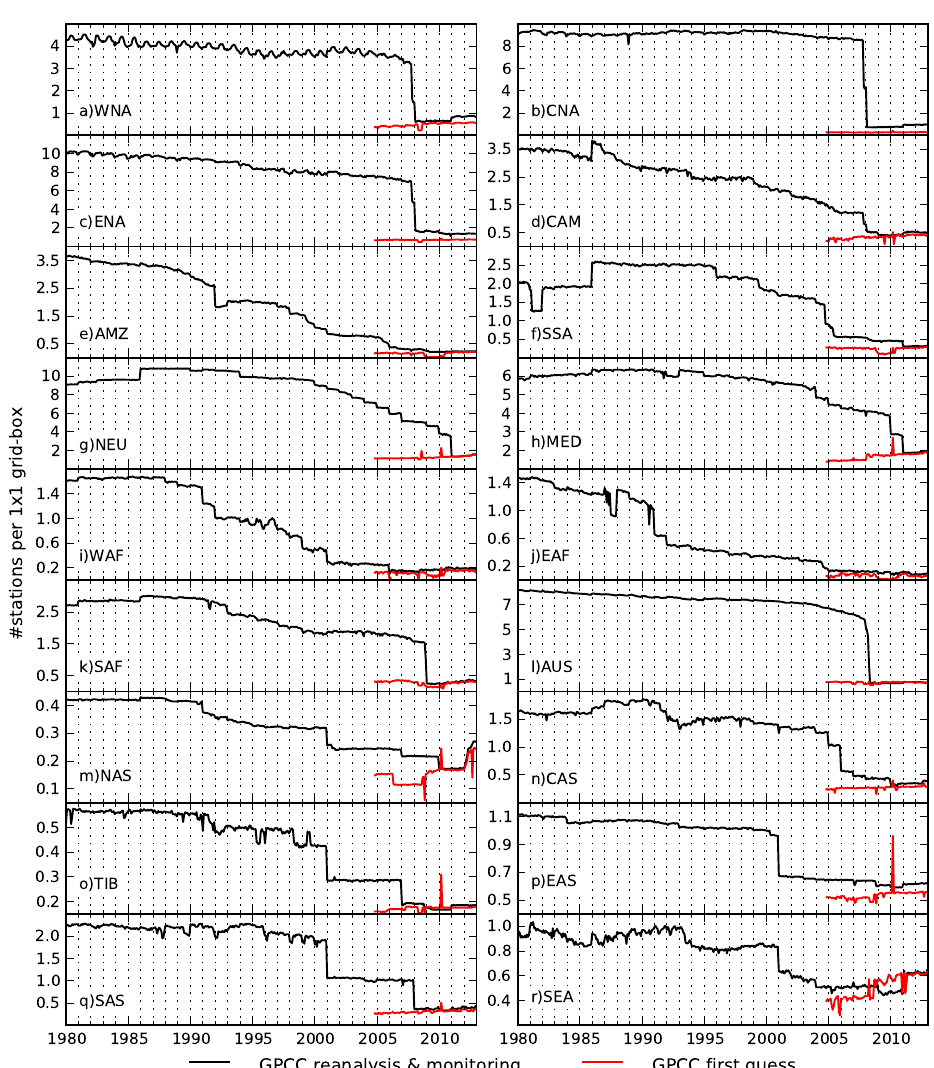
Figure 1. Monthly temporal evolution of the mean number of stations per 1 ◦ × 1 ◦ grid box in the different regions (see Table 2) present in the GPCC reanalysis (until 2010) and monitoring product (2010 onwards) (black line) and GPCC first guess product (red